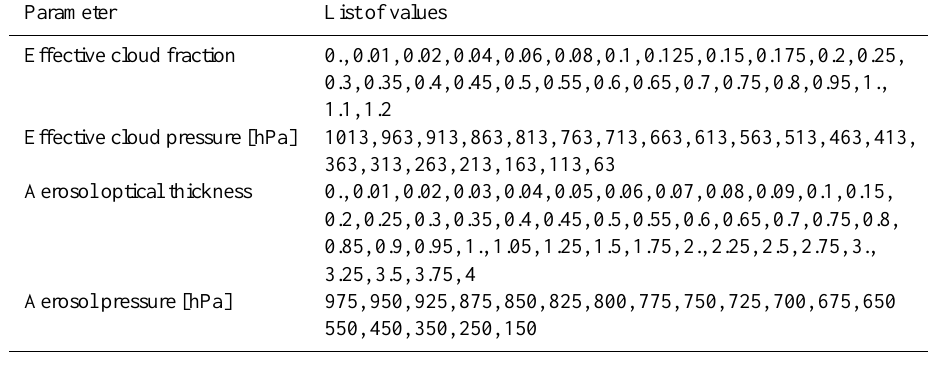
Table 2. List of values considered for the simulation nodes illustrated in Fig. 13: effective cloud fraction, effective cloud pressure, aerosol optical thickness, and aerosol pressure.